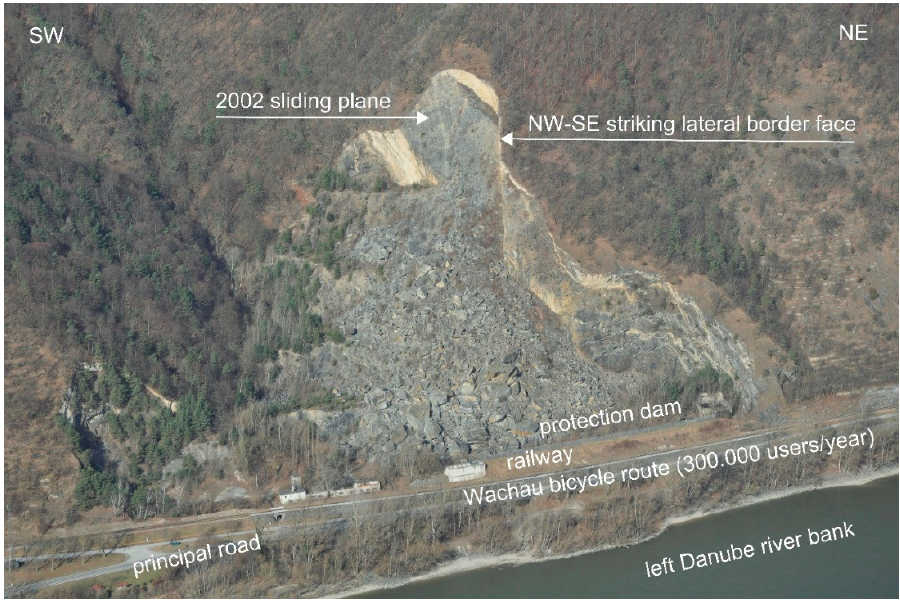
Figure 1. The current state of the former quarry of Spitz.